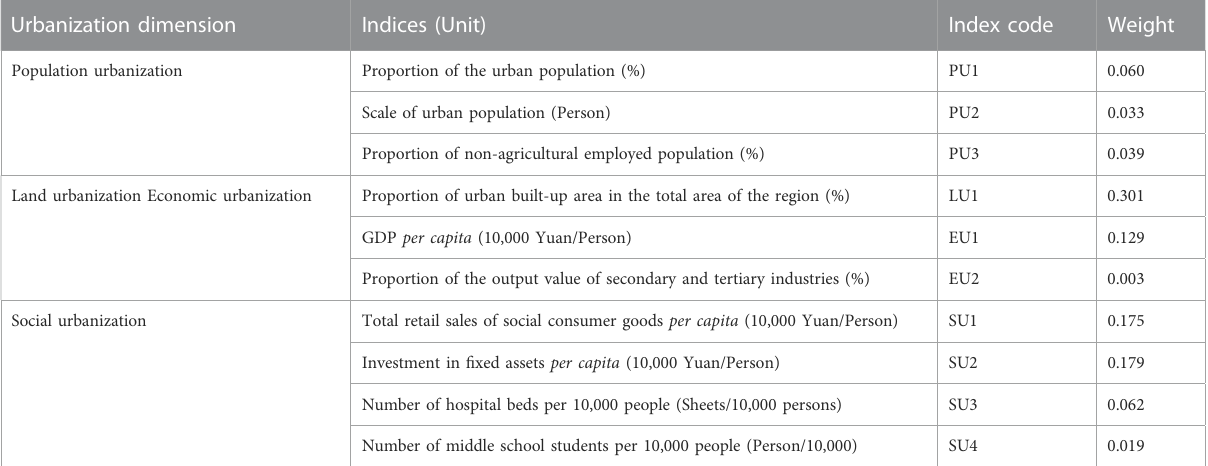
TABLE 1 Evaluation index system and weight of